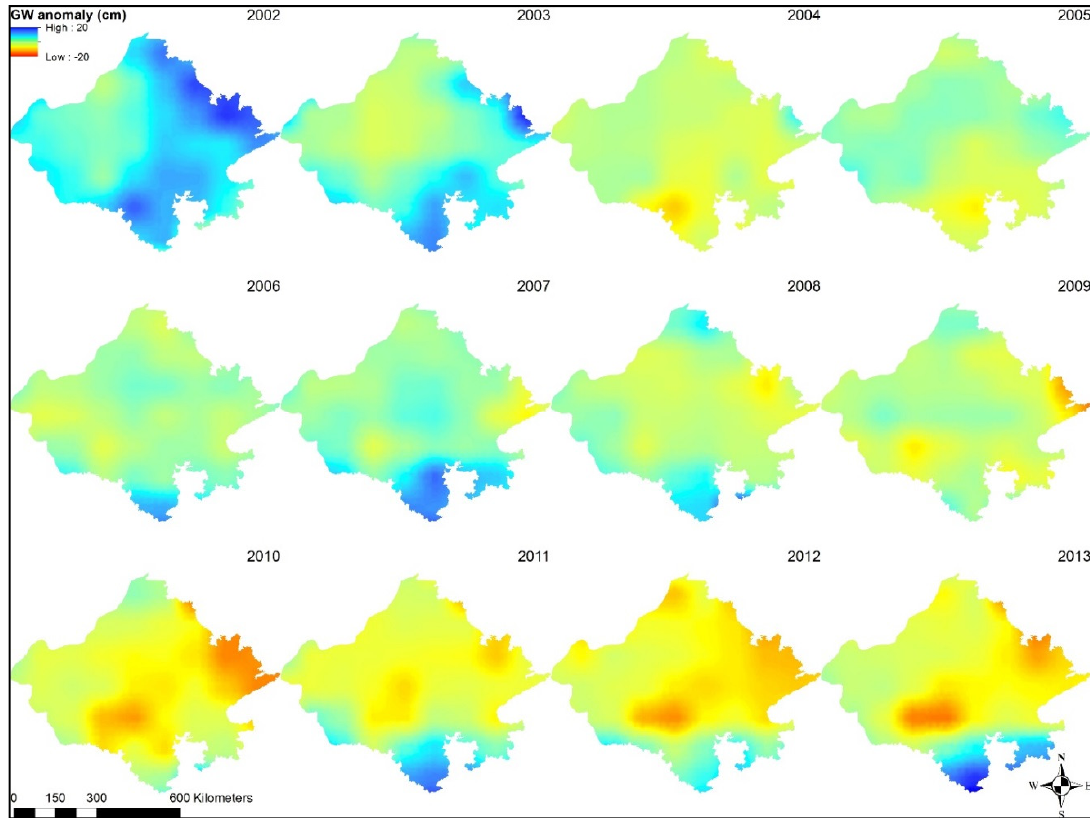
Figure 6. GRACE estimates of groundwater storage anomaly for the Indian state of Rajasthan for the month of